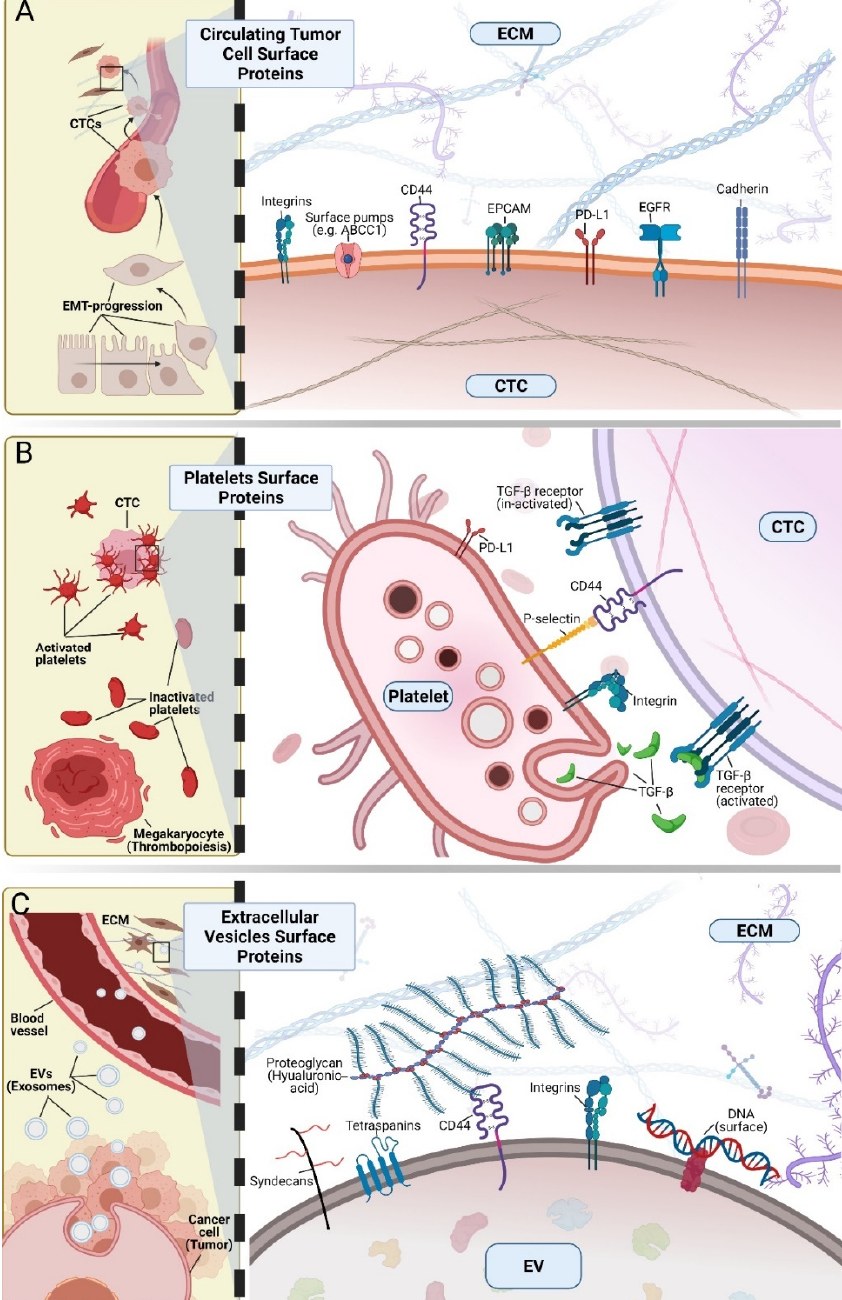
Figure 1. Surface proteins and their interactions in circulating tumor cells (CTCs), platelets and extracellular vesicles (EVs). ( A ) Surface proteins on CTCs. During cancer progression, cancer cells can go through a reconfiguration of their protein expression profile. For instance, in carcinomas, during epithelial-to-mesenchymal transition (EMT), loss of epithelial features (e.g., downregulation or loss of E-cadherin) allows the dissemination of tumor cells, as well as interactions with endothelial cells and the extracellular matrix (ECM). Relevant examples are interactions with CD44, integrins and